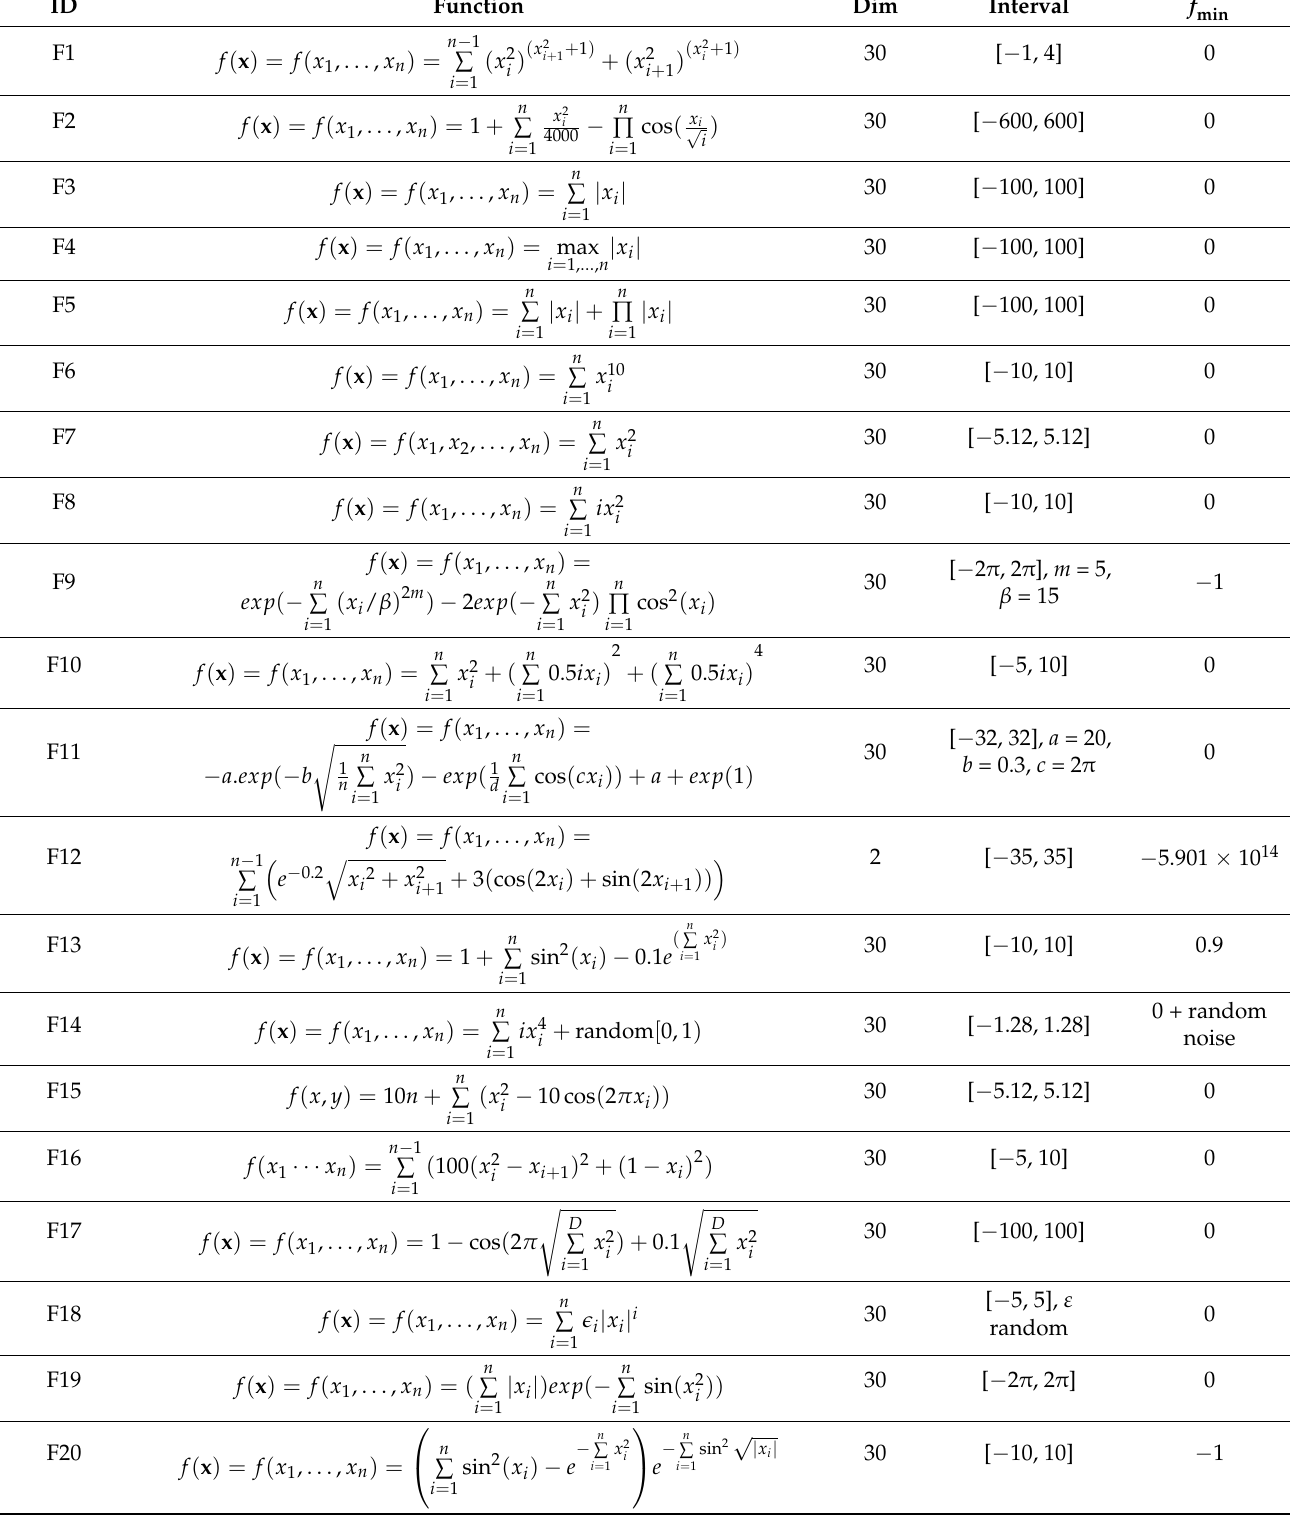
Table A2. Description of the Testbench